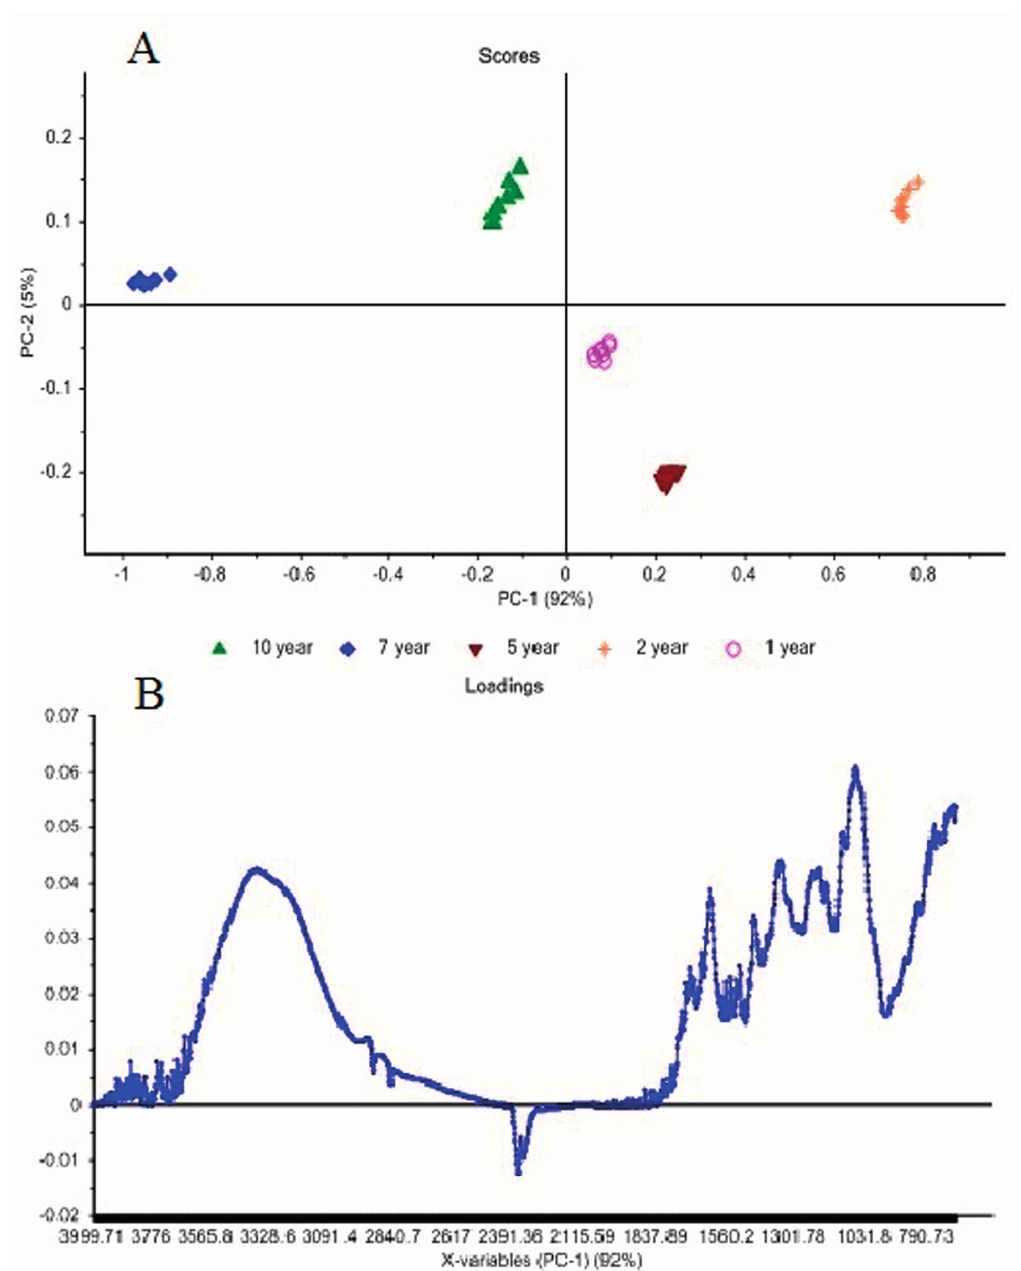
Figure 3. Principle Component Analysis (PCA) Score Plot ( A ) and Loading Plot ( B ) of S. campanulatum plants of different